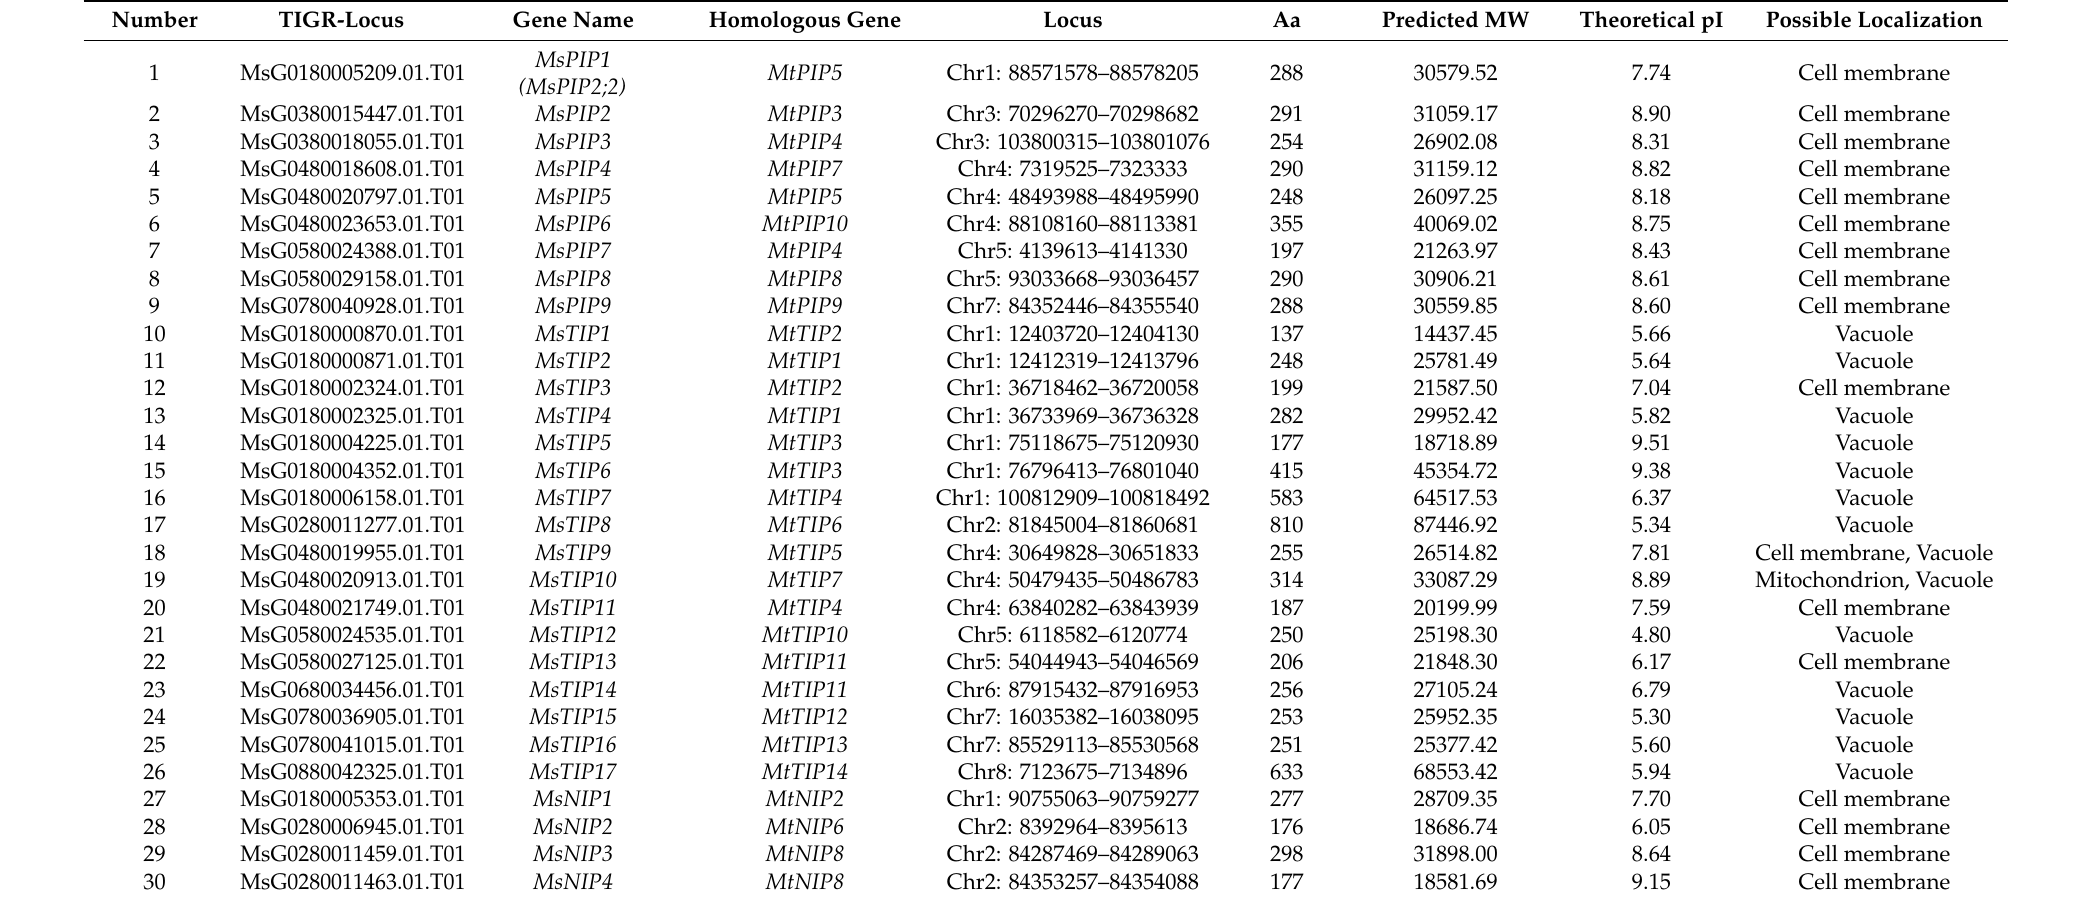
Table 1. Properties of the predicted AQP proteins in M. sativa